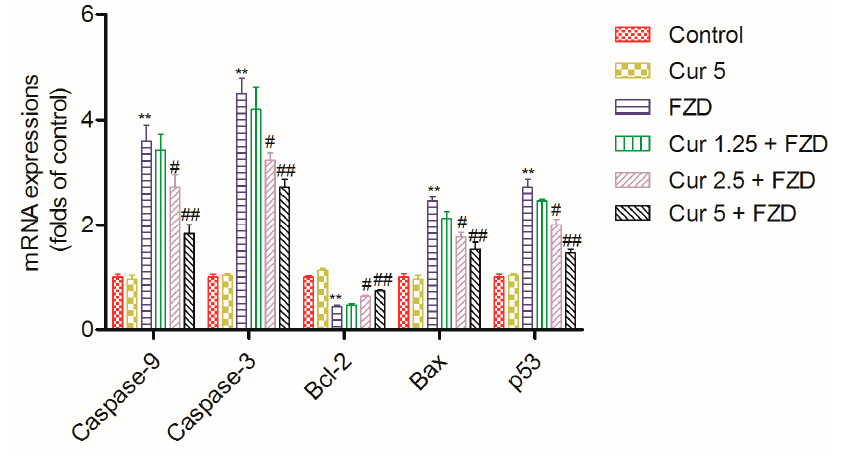
Figure 7. Curcumin treatment ameliorates the mRNA expression levels of apoptosis related factor caused by FZD exposure. Values were presented as mean ± SD, from three independent experiments. ** p < 0.01, compared to the negative control group; # p < 0.05, ## p < 0.01, compared to the FZD alone treatment group.